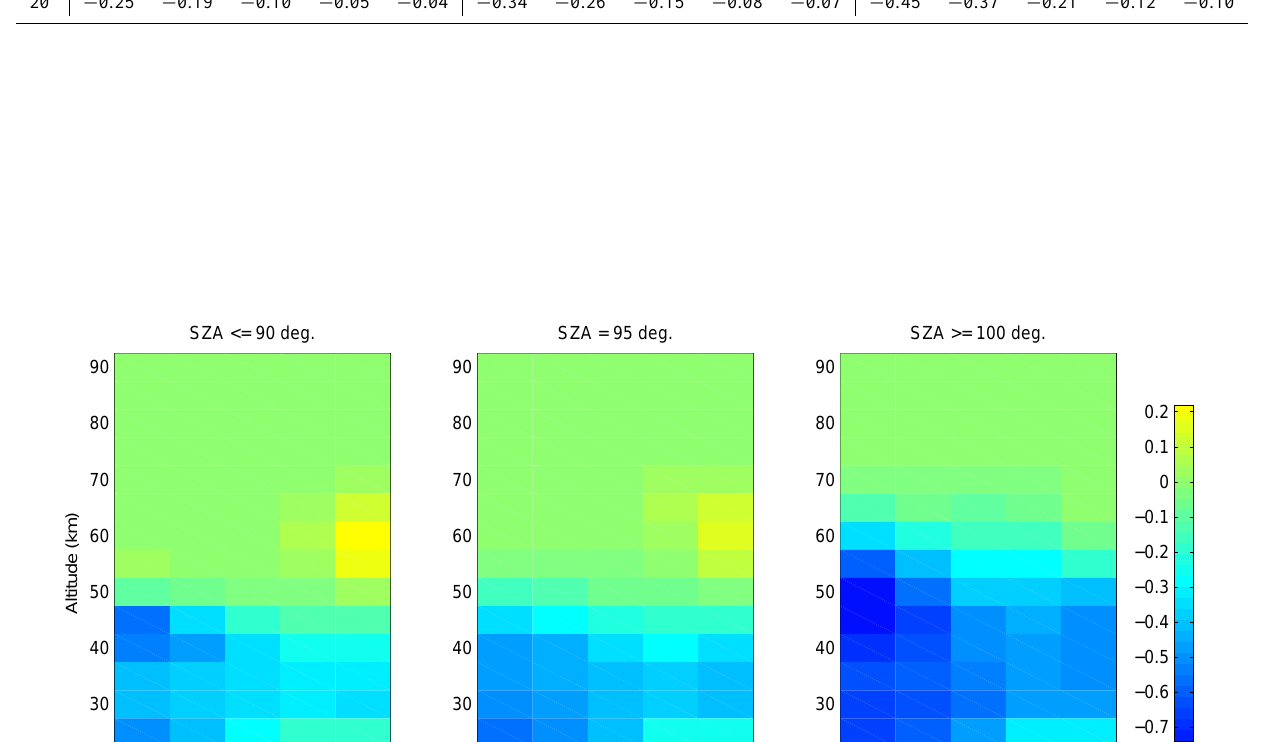
/Q for October 2